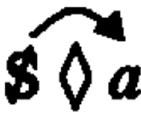
Figure 3. Traversing the Fantasy ([34], p. 62).